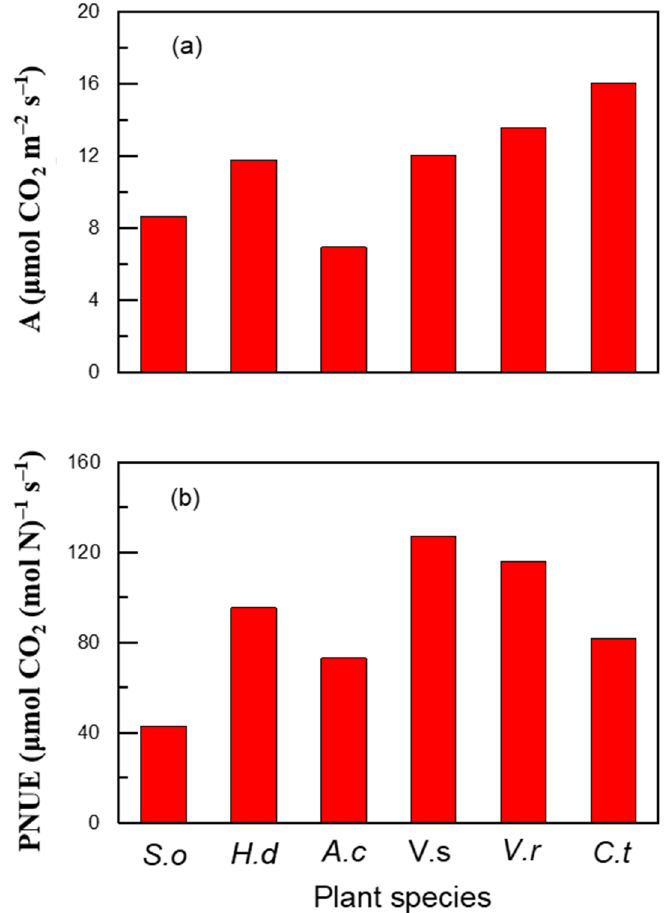
Figure A3. The average photosynthetic rate (A) ( a ) and photosynthetic N use efficiency (PNUE) ( b ) of six species derived from the third sampling campaign. Abbreviation: S. oblate (S.o), H. dulcis (H.d),